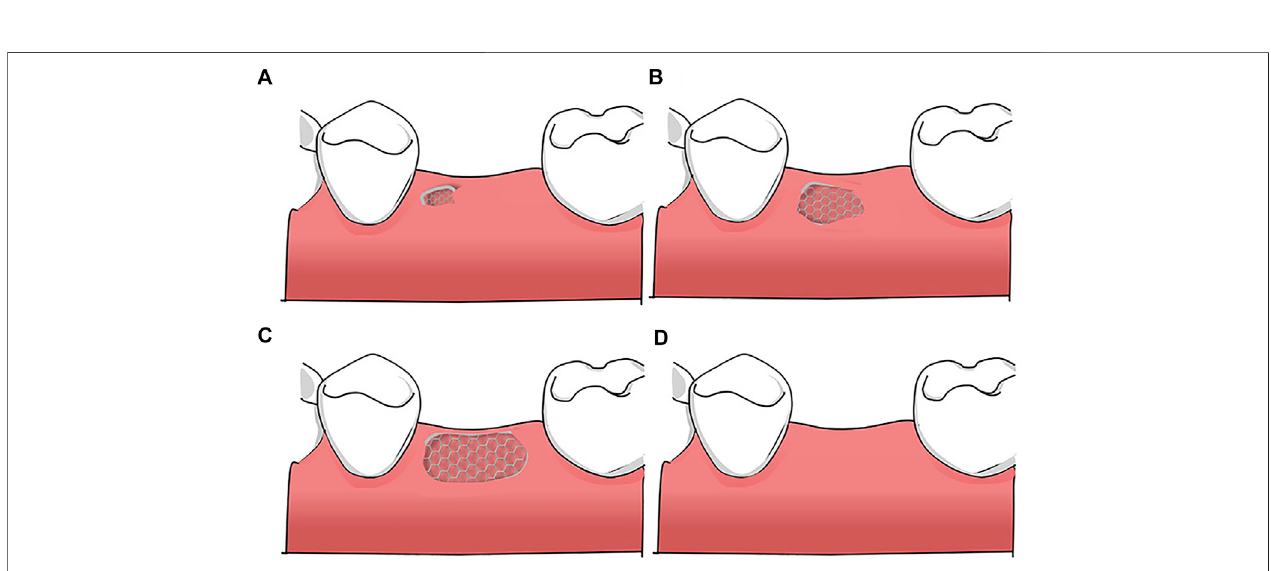
FIGURE 5 | Classi fi cation of mesh exposure: (A) minor exposure; (B) one tooth width exposure (premolar); (C) exposure of an entire mesh (D) no exposure.